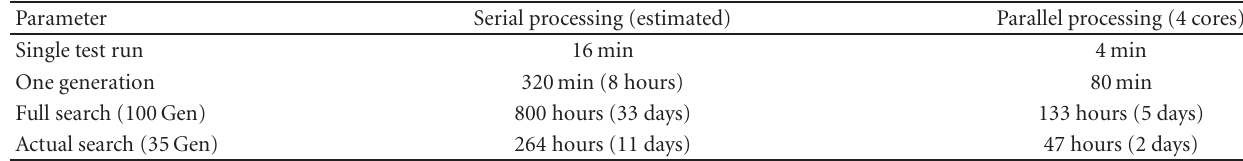
Table 3: Comparison of search time using genetic algorithms using serial processing and parallel